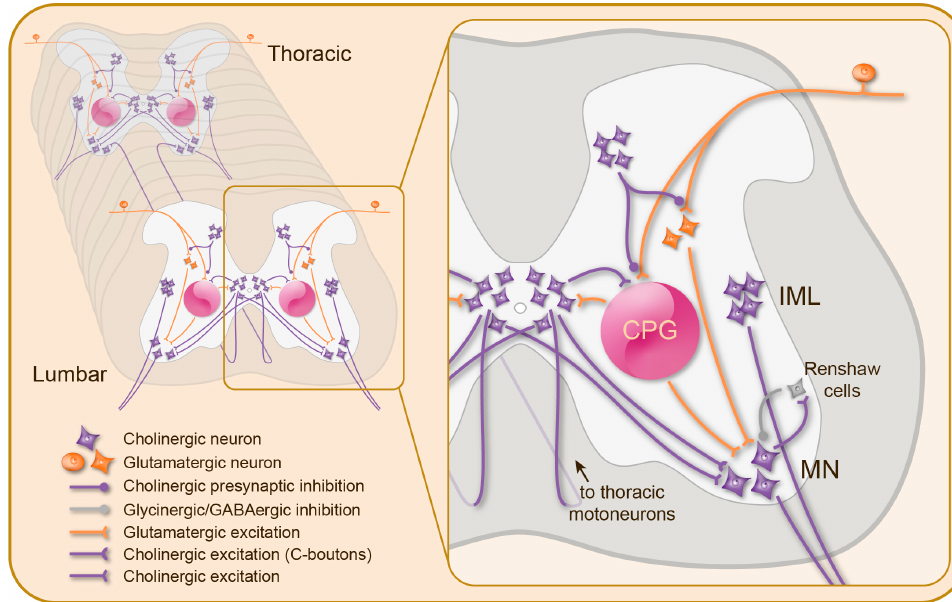
Figure 2. Cholinergic neuromodulation of spinal motor networks. Motoneurons (MN), intermedio- lateral neurons (IML), and propriospinal interneurons are the only sources of acetylcholine (purple) in the spinal cord, while local glutamatergic excitation (orange) is provided by segmental sensory afferents and interneurons, some of which are part of the central pattern generator (CPG) for loco- motion. Except for a group of dorsal interneurons that perform a presynaptic inhibition (filled circle) onto the primary afferent terminals, all propriospinal cholinergic interneurons exert excitation on a variety of cellular targets, including motoneurons (notably via the well described C-boutons) and CPG interneurons.